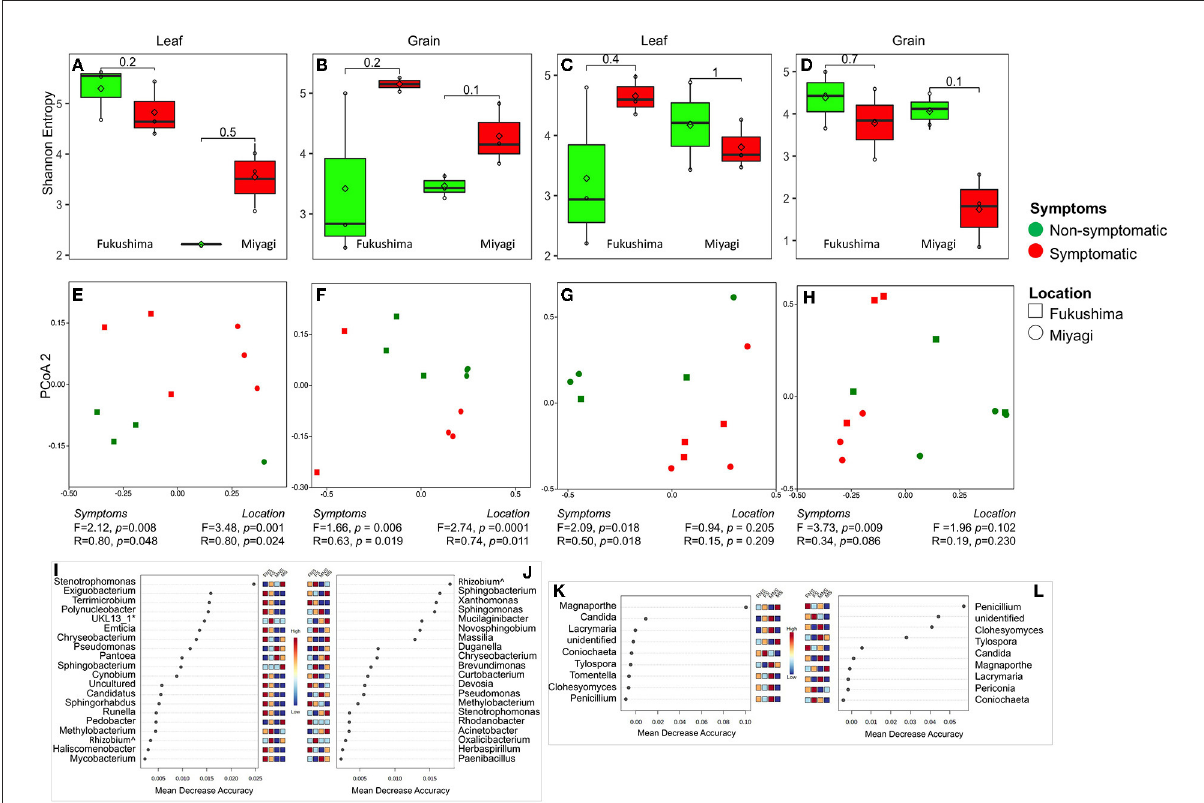
FIGURE2 Bacterial and fungal microbiome community of rice leaf and grain as influenced by fungal pathogen infection: Alpha diversity (Shannon Entropy) of bacterial (A,B) and fungal (C,D) community in leaf (A,C) and grain (B,D) tissues. PCoA, ANOSIM, and PERMANOVA-based analyses of bacterial (E,F) and fungal (G,H) microbiome of symptomatic and asymptomatic samples of leaf (E,G) and grain (F,H) samples of rice collected from two locations in Japan. Random forest analysis results of bacterial (top 20) (I,J) and fungal (K,L) genera with the highest discriminatory power between symptomatic and asymptomatic tissues of leaf (I,K) and grain (J,L) . Red fields show a high abundance and blue fields a low abundance of the particular bacterial genera. FNS, Fukushima non-symptomatic; FS, Fukushima symptomatic; MNS, Miyagi non-symptomatic; MS, Miyagi symptomatic.